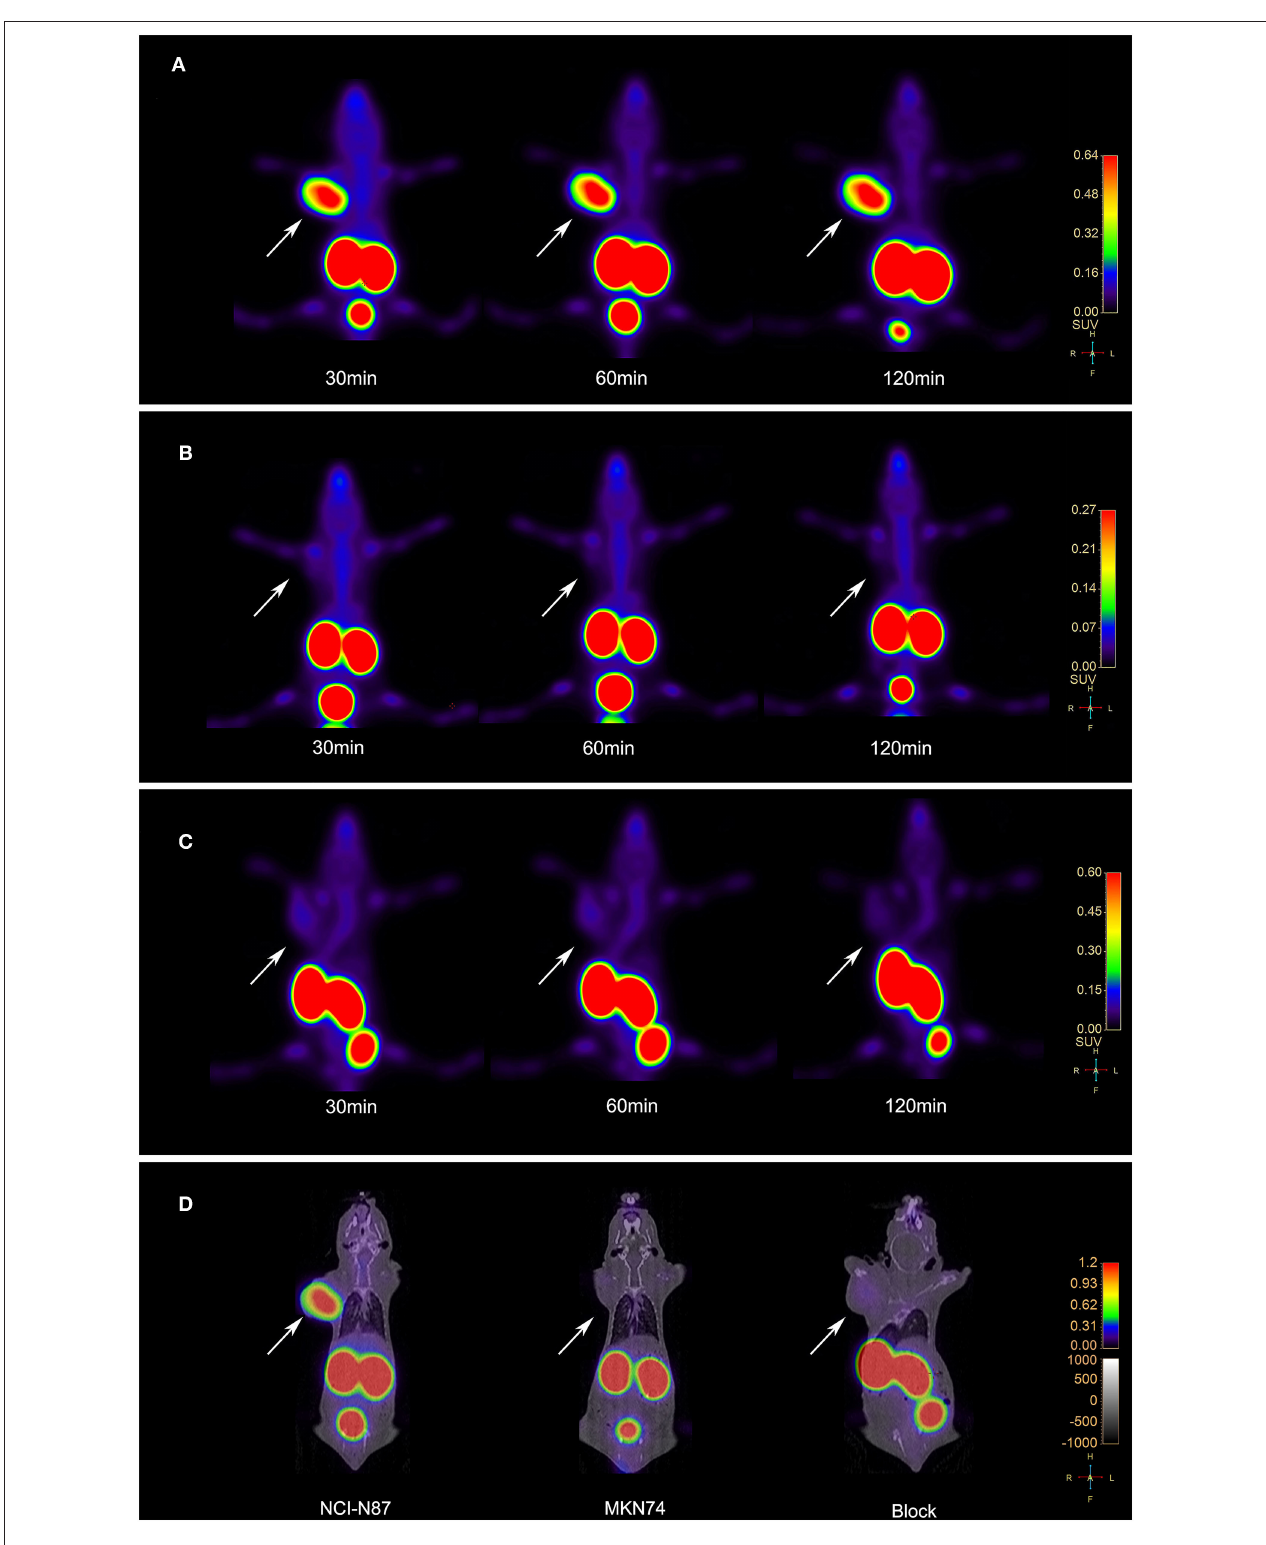
FIGURE 5 | (A) Vereos PET images of the [ 18 F]AlF-NOTA-HER2 affibody in tumor-bearing mice NCI-N87 xenografts. (B) Vereos PET images of the [ 18 F]AlF-NOTA-HER2 affibody in tumor-bearing mice MKN74 xenografts. (C) Blocking study after a coinjection with excess cold NOTA-HER2 affibody in mice-bearing NCI-N87 tumors. (D) Fusion images of mouse model at 60min post-injection by Vereos PET/CT. White arrows indicate xenografts.